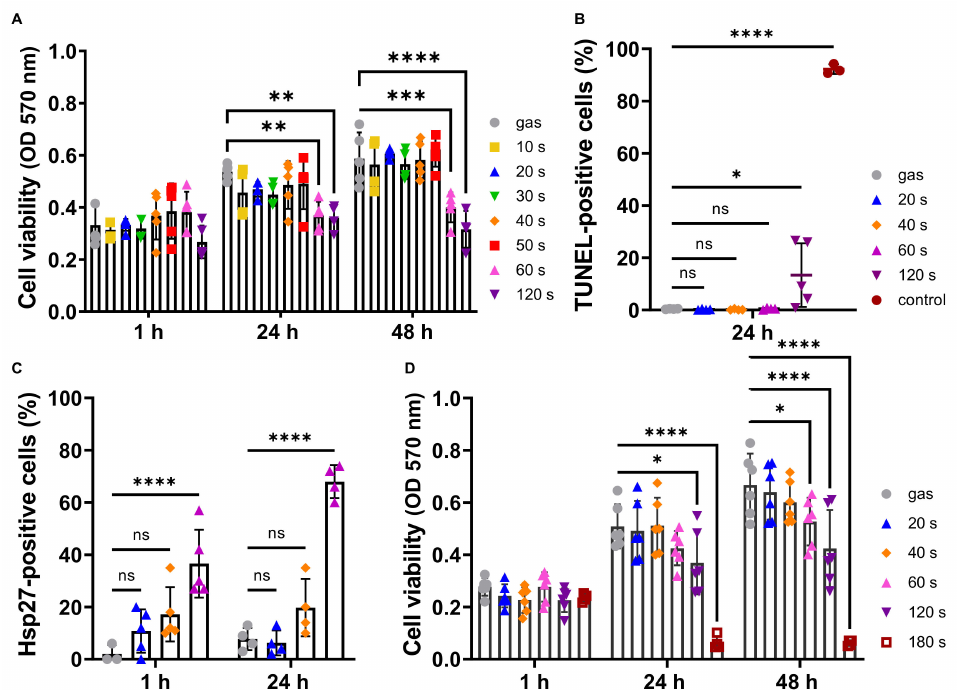
Figure 1. CAP treatments of less than 40 s did not affect keratinocyte proliferation and viability. N/TERT-1 keratinocyte cell line ( A – C ) and human primary keratinocytes ( D ) were exposed to CAP for the indicated periods of time. Cell viability was then determined using an MTT assay 1 h, 24 h and 48 h after CAP exposure ( A , D ), with cells treated with gas alone for 120 s as control; n ≥ 3. Induction of N/TERT-1 apoptosis was evaluated with a TUNEL assay 24 h after CAP treatments ( B ), 1 µ M staurosporine being used as positive control; n = 3. Induction of heat stress was determined by immunocytochemistry on N/TERT-1 keratinocytes using an anti-HSP27 antibody, 1 h and 24 h after CAP exposure ( C ); n = 3. Error bars represent S.D.; *, p < 0.05; **, p < 0.005; ***, p < 0.001; ****, p < 0.0001; ns: not